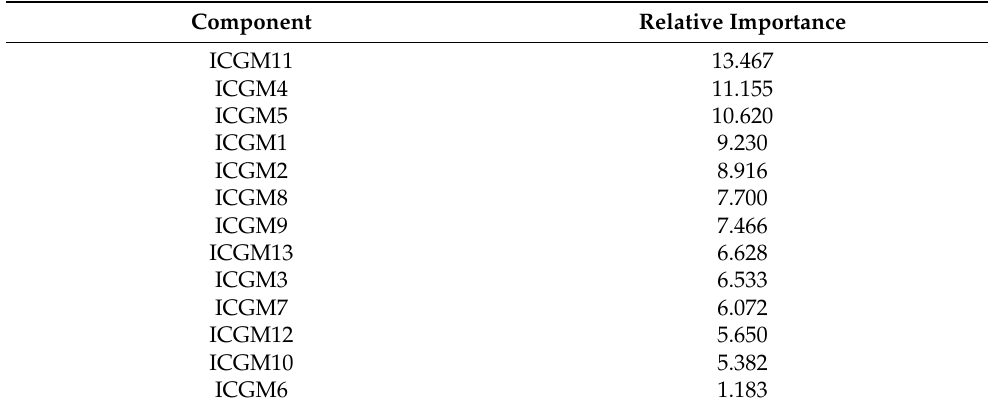
Table 1. Relative importance of the components in the decision tree Regression